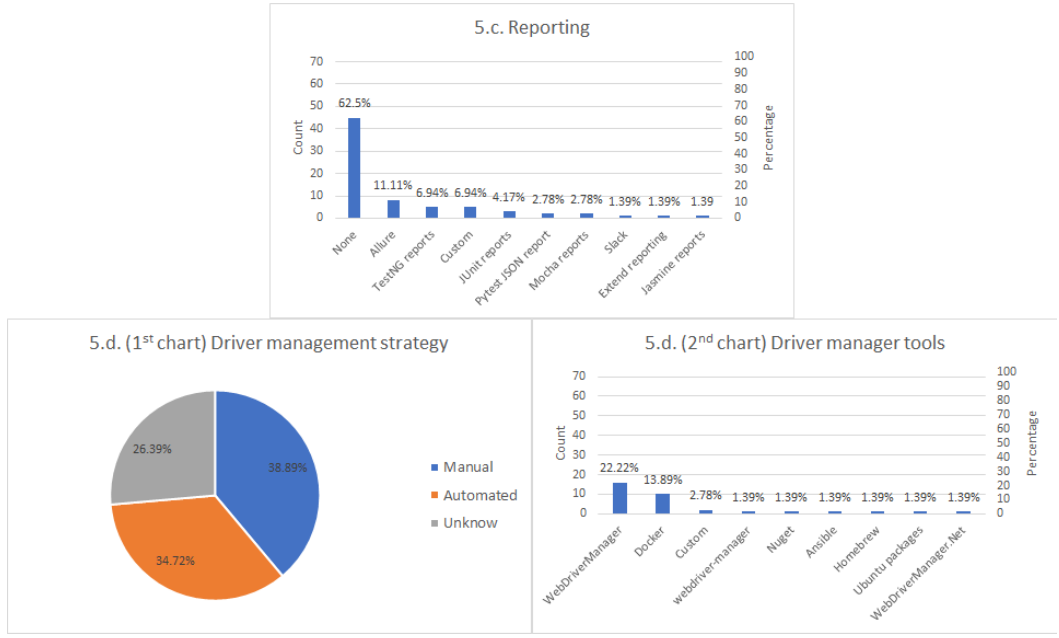
Figure 13. Reporting tools and driver managers for Selenium WebDriver.